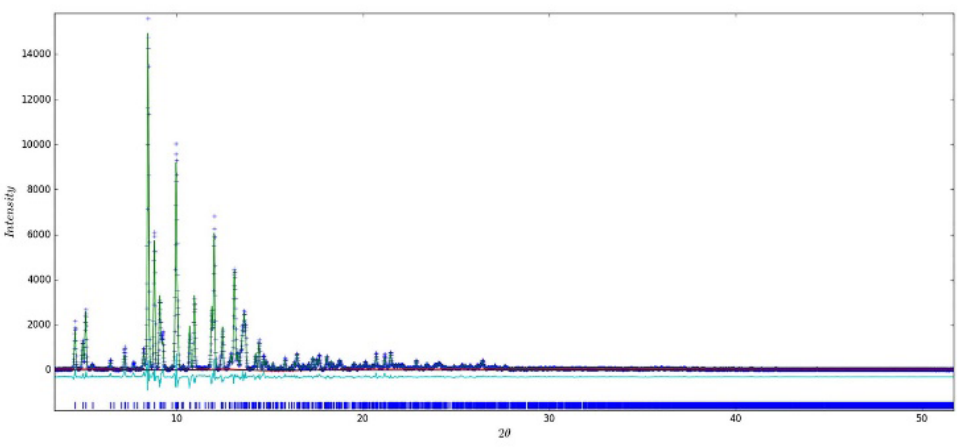
Figure 3: Observed (+) in blue, calculated (-) in green and difference in cyan X-ray profiles for the final Rietveld refinement of the molecule. Bragg reflection markers in blue were shown